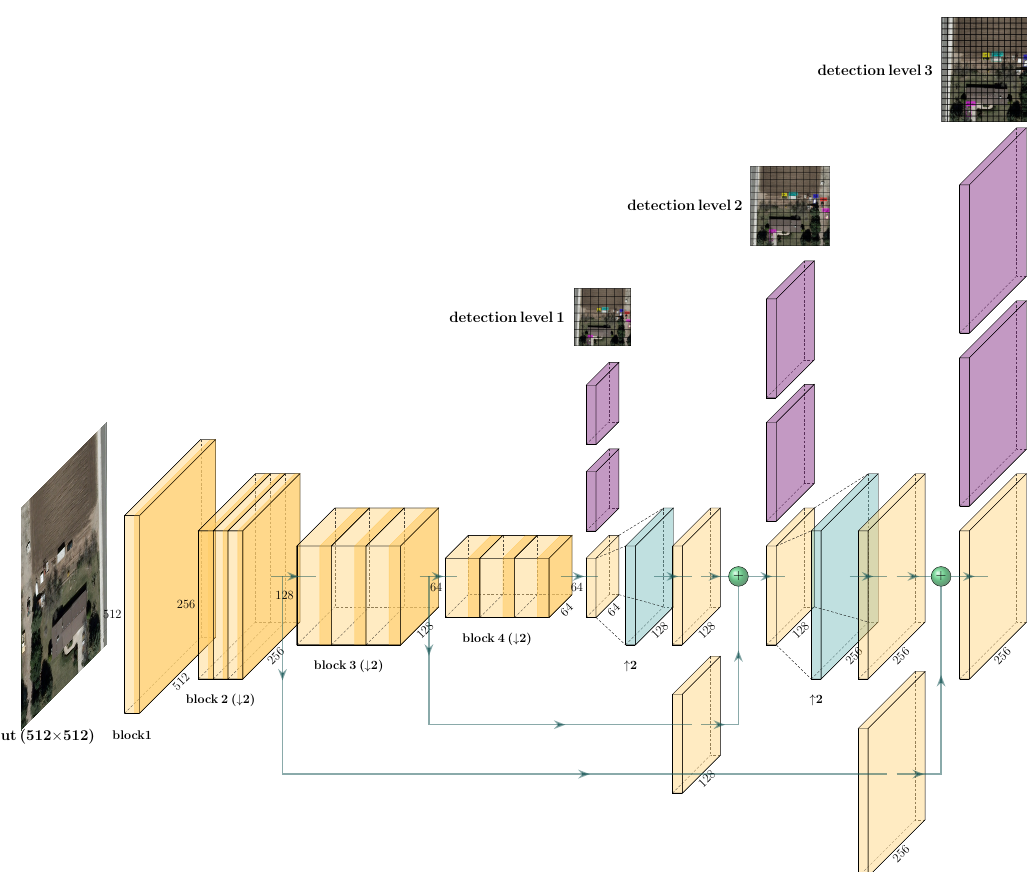
Figure 2. The YOLO-fine framework, including residual blocks (yellow), detection layers (magenta), and upsampling layers